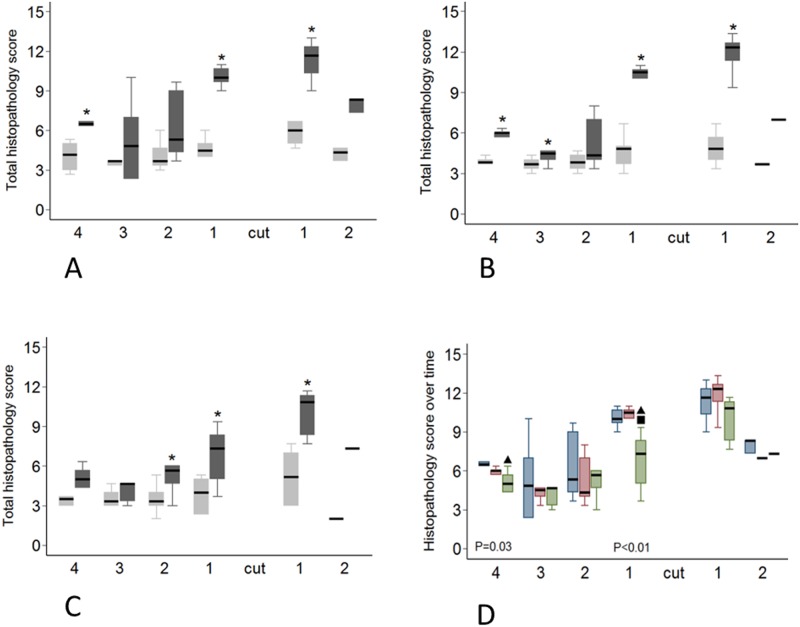
Regional variation in histopathology score.Transected tendons are represented by the dark grey box and control tendons by the light grey box. Significant differences (P<0.05) between transected and control tendons as determined with a Wilcoxon signed-rank test are indicated by the asterisk. A-C: Variation in histopathology score at 8 weeks (A), 12 weeks (B) and 16 weeks (C). D: Histopathological score in transected tendons at 8 (blue boxes), 12 (red boxes) and 16 weeks (green boxes). Significant differences between time points (P<0.05, determined with a Mann-Whitney U test) are indicated by the black triangles (8 weeks significantly different to 16 weeks) and the black square (12 weeks significantly different to 16 weeks).